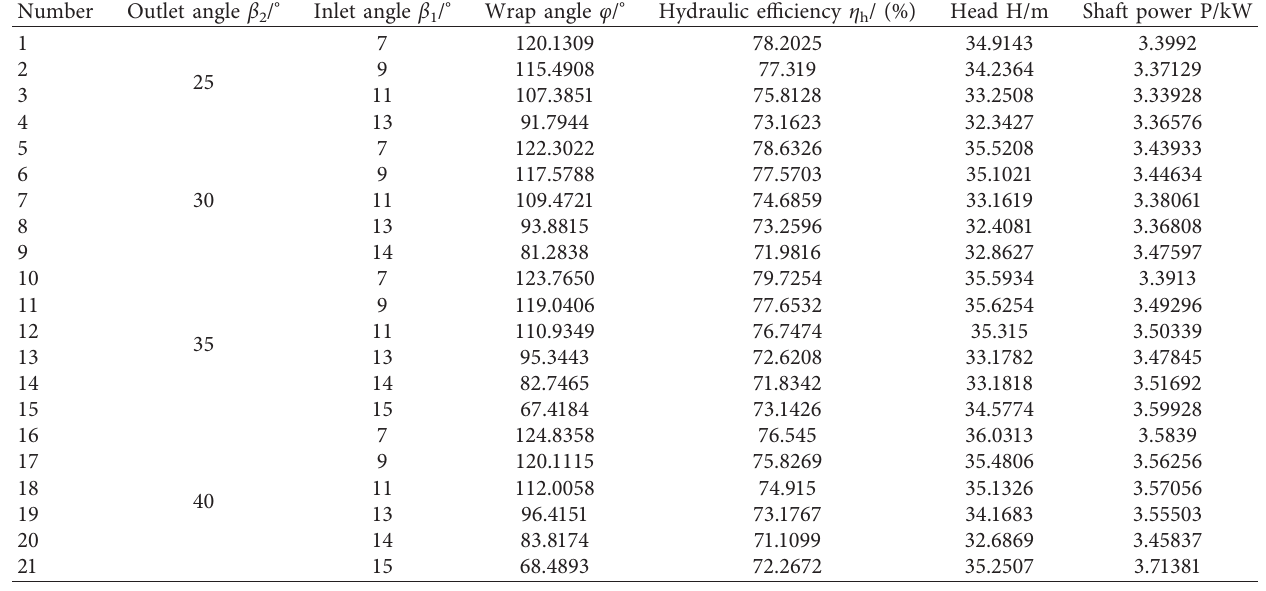
Table 4: External characteristic parameter under different model working conditions.